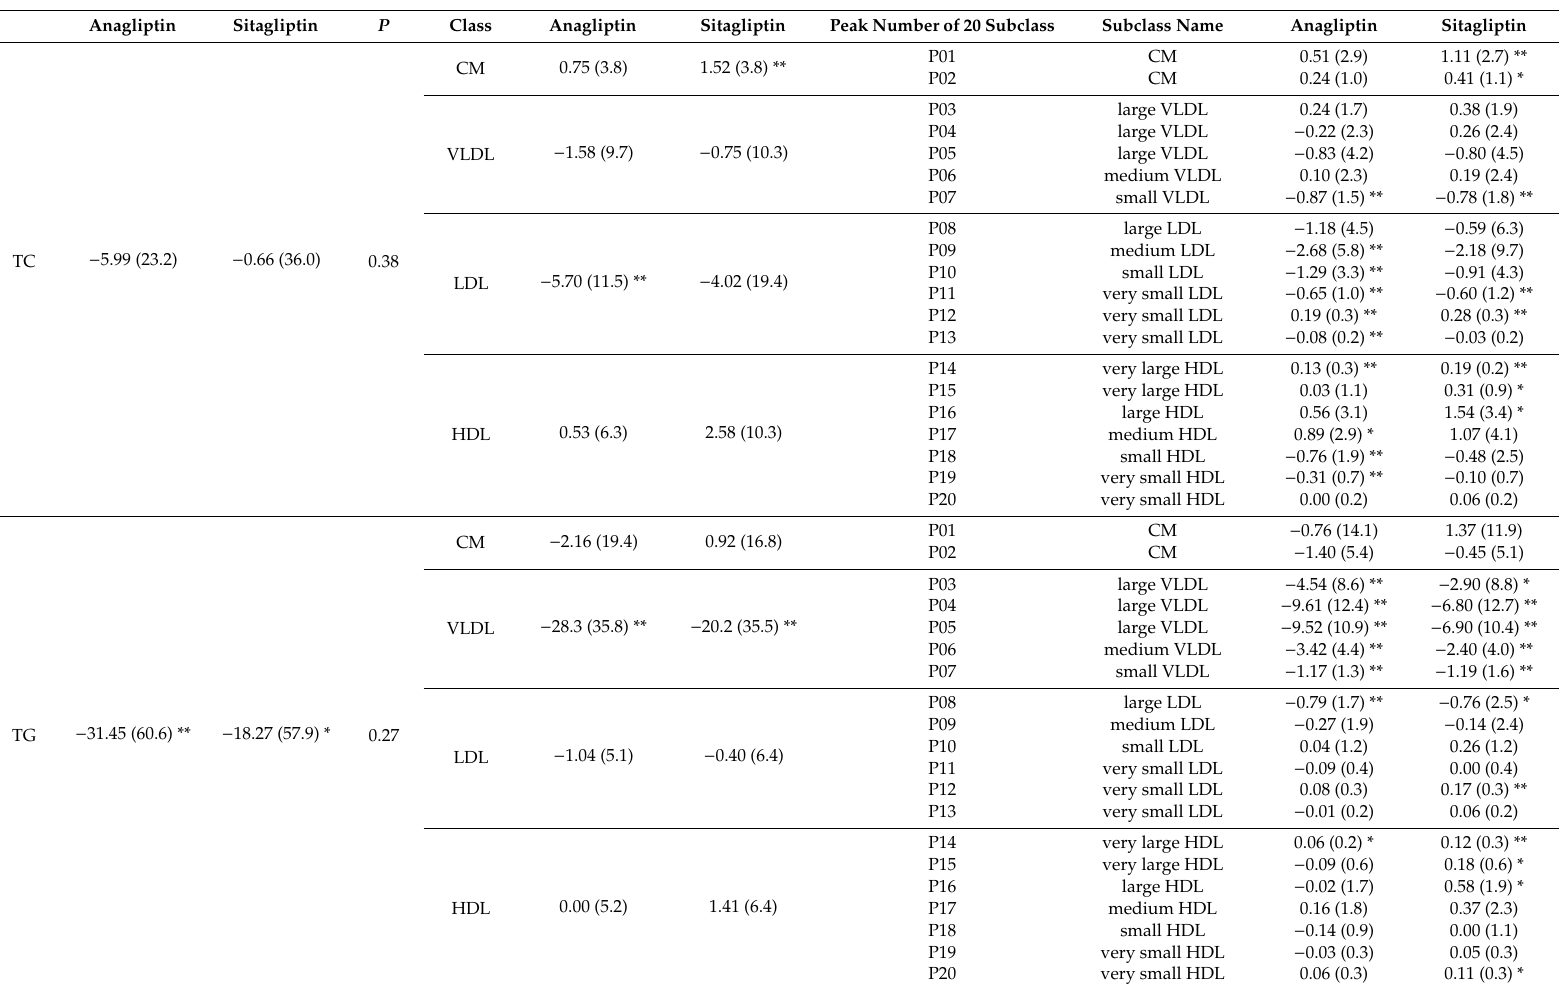
Table 2. Di ff erences in total cholesterol and triglycerides in lipoprotein classes and subclasses in patients treated either with anagliptin or sitagliptin. All